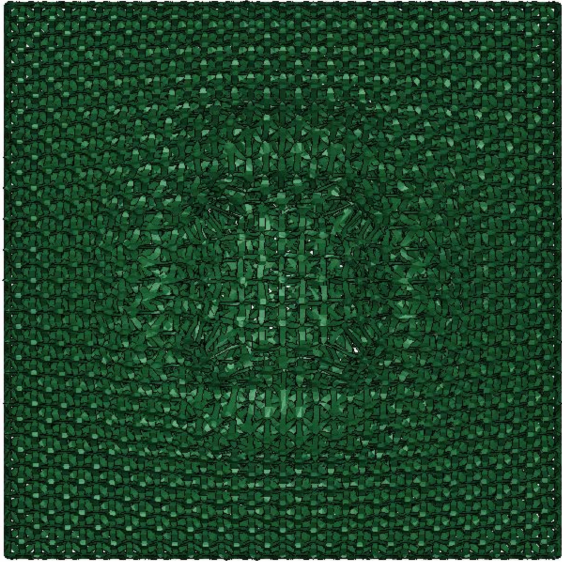
Figure 17. The damage of the optimized lattice structures after